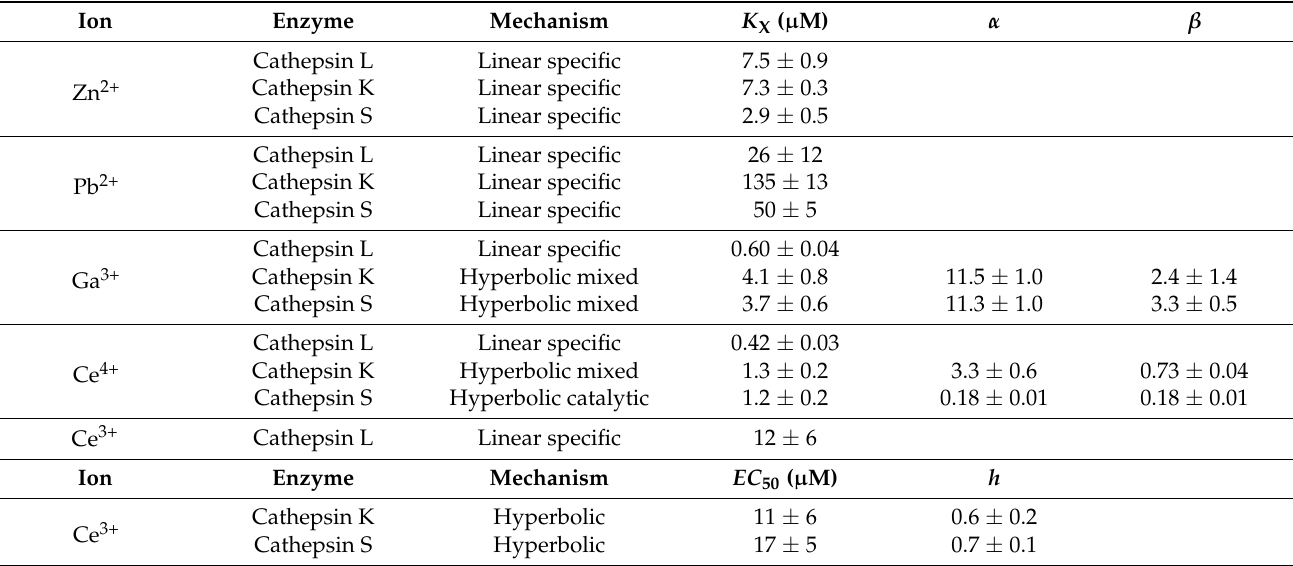
Table 1. Kinetic parameters for the inhibition of cysteine cathepsins L, K, and S by selected metal ions.